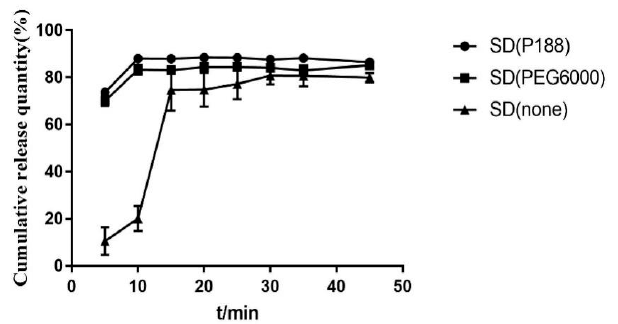
Figure 4. Dissolution curves of solid dispersion prepared by different plasticizer.